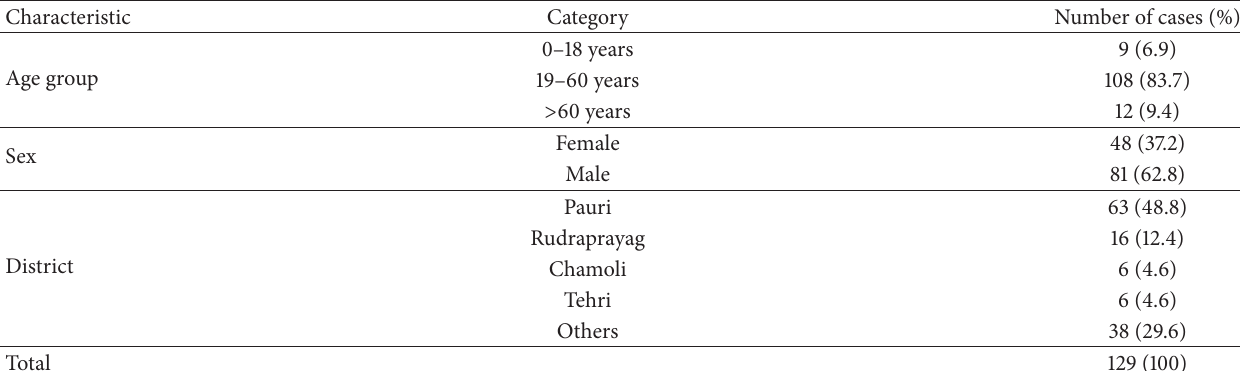
Table 1: Demographic profile of new cases of leprosy in a tertiary care hospital in Srinagar, Garhwal, North India (2009–2014). Characteristic